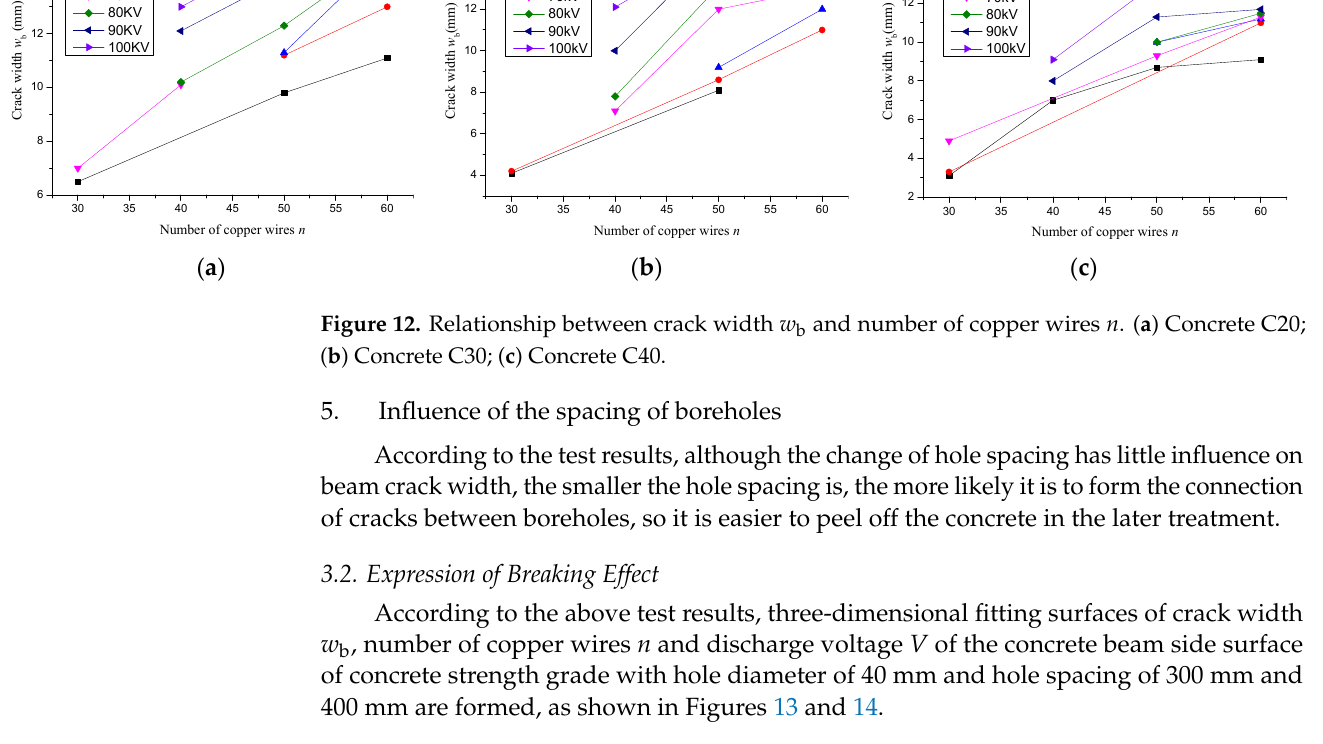
( c ) Figure 11. Relationship between crack width w b and discharge voltage V . ( a ) 40 copper wires; ( b ) 50 copper wires; ( c ) 60 copper wires. 4.